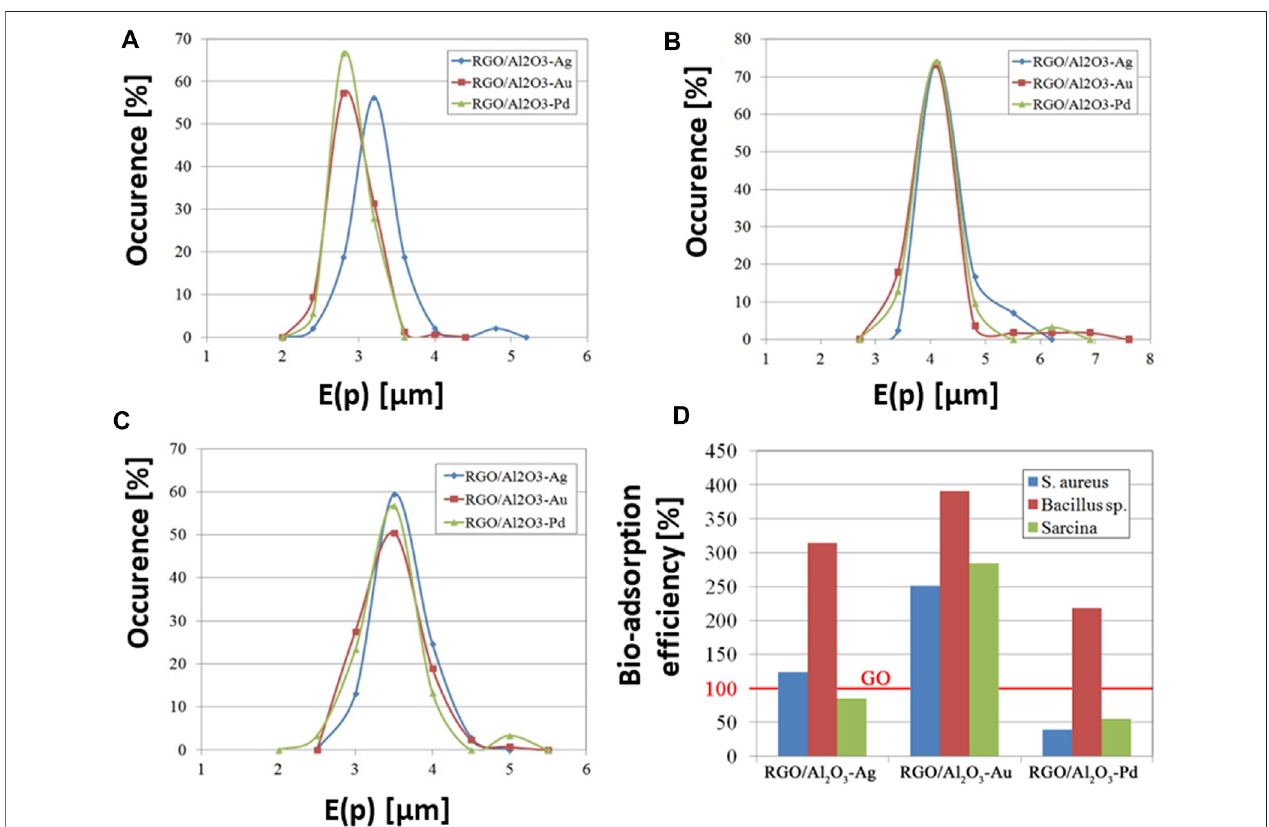
FIGURE 13 | Analysis of changes in the shape of bacteria cells absorbed on the surface of the RGO/Al 2 O 3 -Me nanocomposites, presented as distributions of E (p) values for S. aureus (A) , Bacillus sp. (B) , and Sarcina (C) strains (Reproduced with permission from (Jastrze ˛ bska et al., 2017e)). Bacteria adsorption ef fi ciency tested for RGO/Al 2 O 3 -Me nanocomposites in comparison to the reference GO fl akes (D) , for which the benchmark of the 100% ef fi ciency is assumed (Reproduced with permission from (Jastrze ˛ bska et al., 2017e) with minor changes).